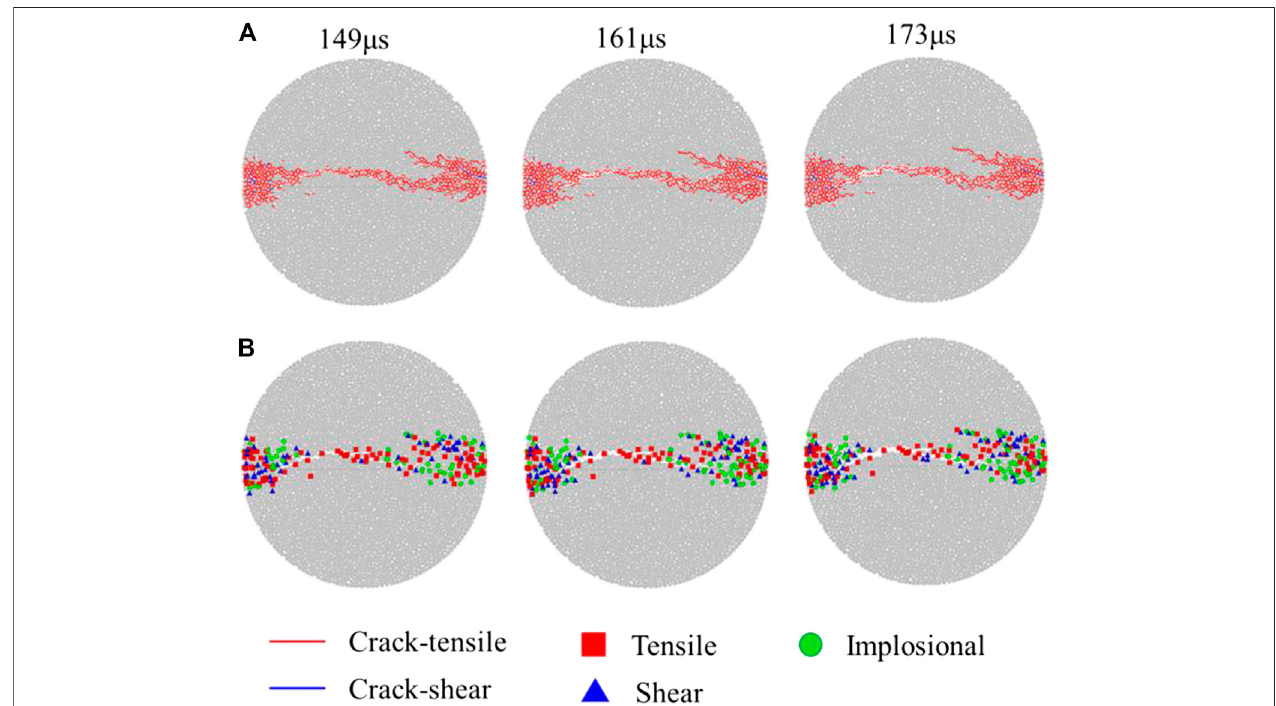
FIGURE 12 | Microscopic mechanism of the shear zones generation in the ends of specimen. (A) is the DFN fracture obtained by the PFC. (B) is the results of the AE source mechanism obtained based on the moment tensor.